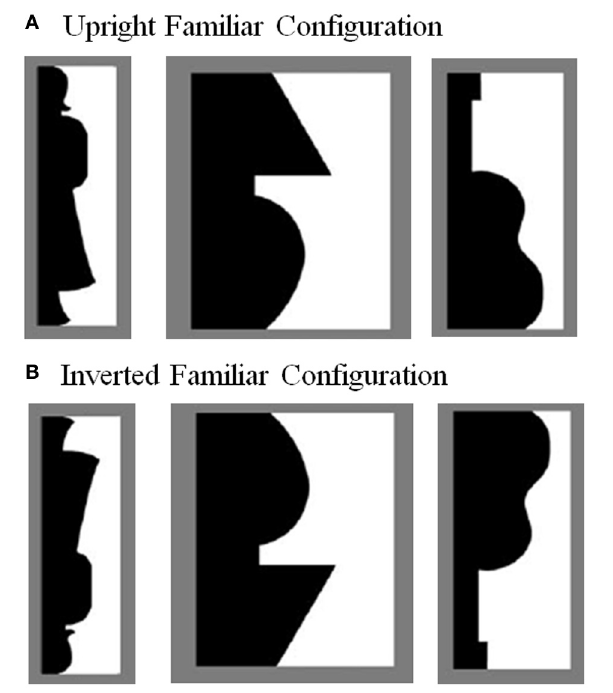
FIGURE 1 | Bipartite figure-ground test stimuli used in this study (see also Peterson et al., 1991, 1998, 2000; Gibson and Peterson, 1994; Barense et al., 2012). Familiar configurations were either (A) upright or (B) inverted. For display purposes, the familiar regions here are always shown in black and on the left (this was fully counterbalanced in the experiment). Shown here in the critical regions are, from left to right, a standing woman, a lamp, and a guitar. Figure modified and reproduced with permission from Gibson and Peterson (1994), Peterson et al. (1998, 2000), Barense et al.